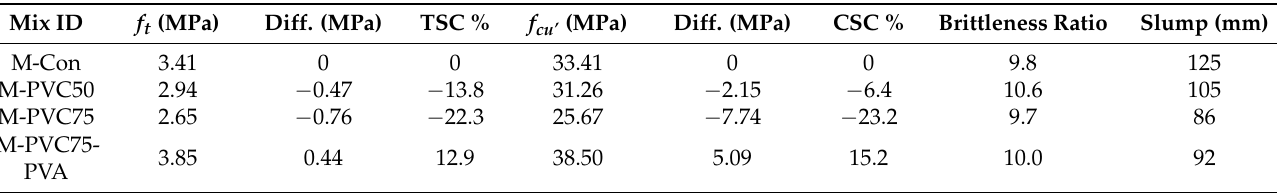
Table 6. Mechanical properties of concrete